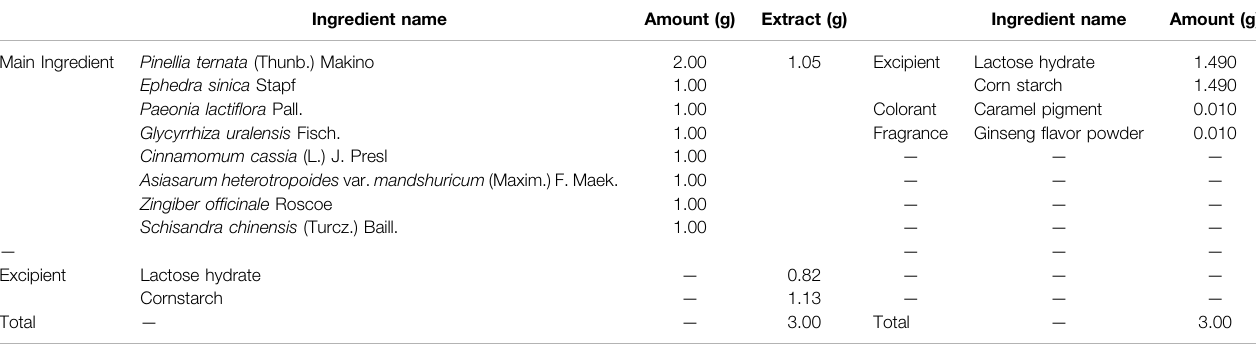
TABLE 1 | Ingredients of the SCRT granules and